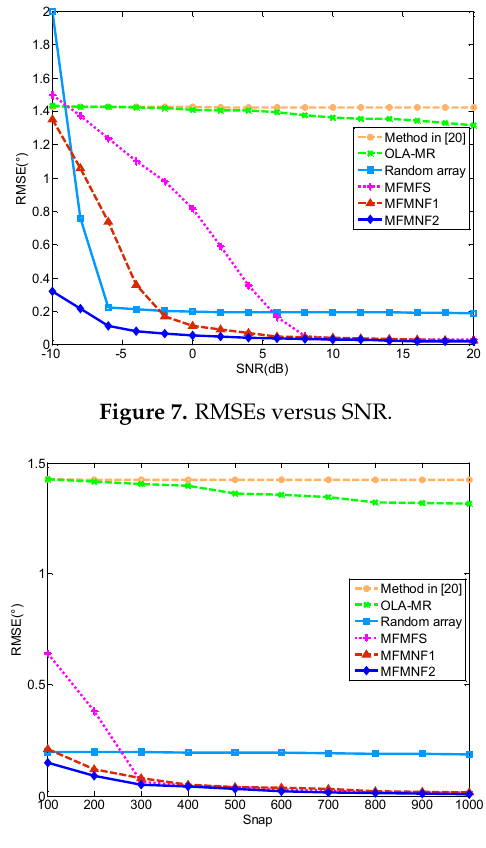
Figure 8. RMSEs versus SNR.